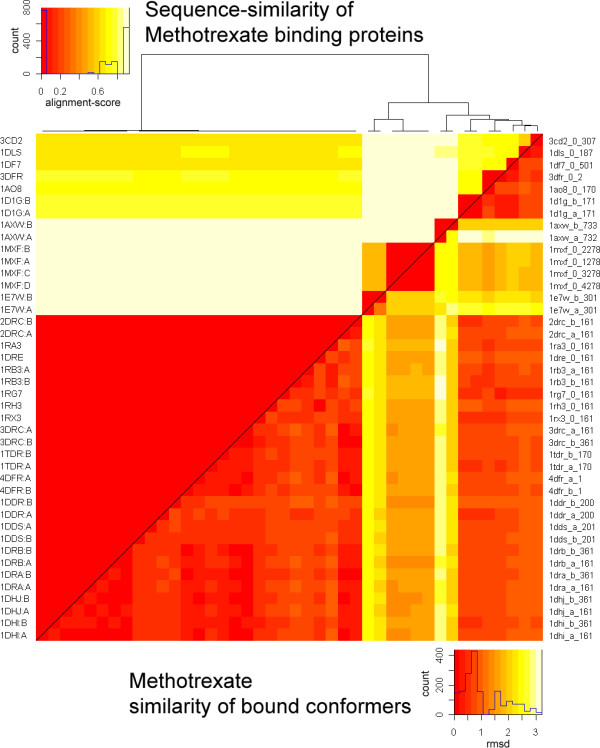
Sequence similarity compared to spatial similarity of bound ligands. The upper left site represents the sequence similarity of Methotrexate binding proteins. The lower right represents the rmsd-values of associated ligand superpositions. See text for further information.